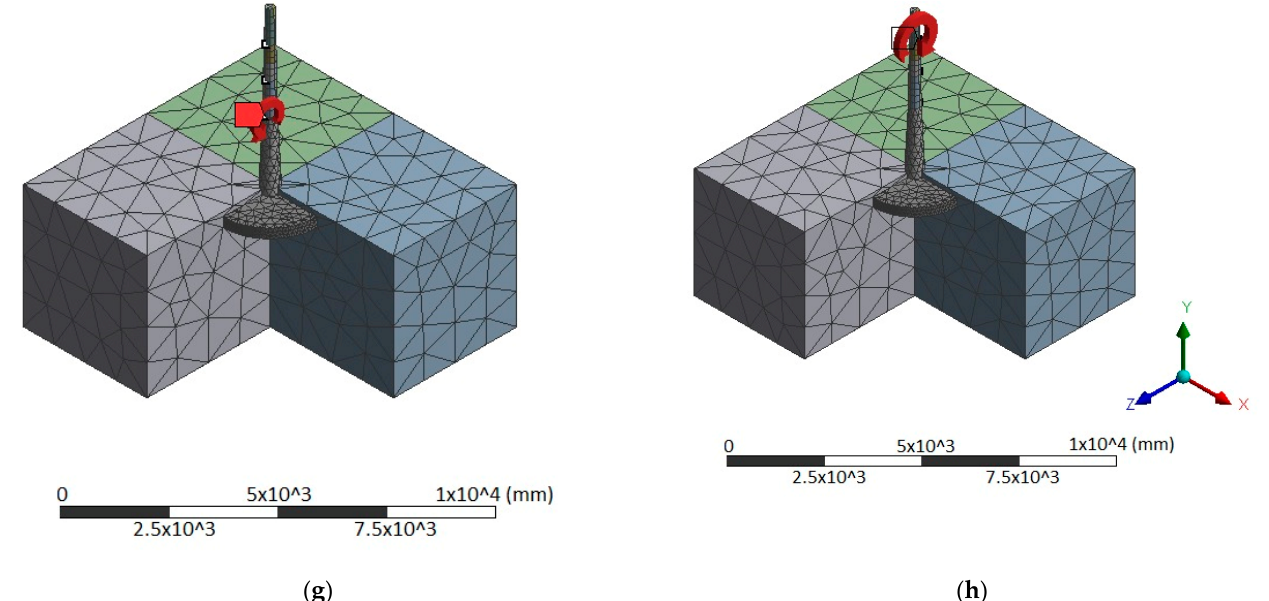
Figure 1. Schematic representation of the architecture of the tree used in the model ( a ); simplification of the crown geometry ( b ); simplified tree without leaves and disregarding the smallest branches ( c ) view of the conical trunk, root disk, and soil bin exemplifying the horizontal force applied to the gravitational center of the crown ( d ); and schematic representation of the levels and directions of moments applied to the trunk to simulate the effect of the branches ( e – h ); where ( e ) is the moment around Z axis with negative direction; ( f ) is the moment around Z axis with positive direction; ( g ) is moment around X axis with positive direction; and ( h ) is the moment around X axis with negative direction.